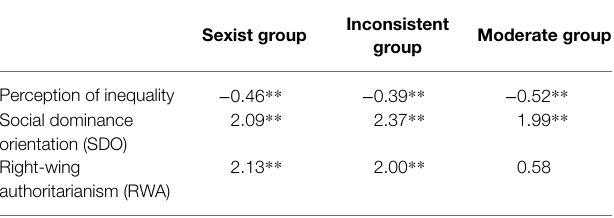
TABLE 2 | Multinomial logistic regression predicting profile membership using the feminist group as the reference